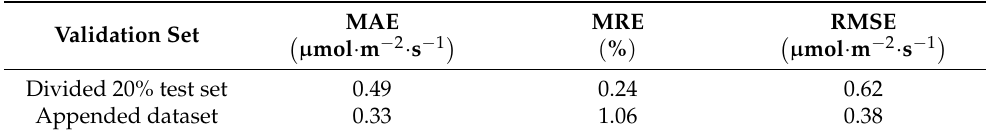
Table 1. Evaluation index of the net photosynthetic rate prediction model. Validation Set